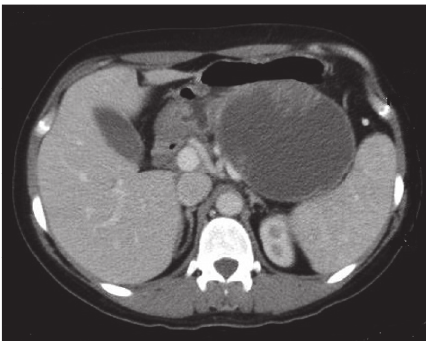
Figure 1: Computed tomography of the abdomen showing a large cystic mass with solid components in the body-tail of the pancreas (case number